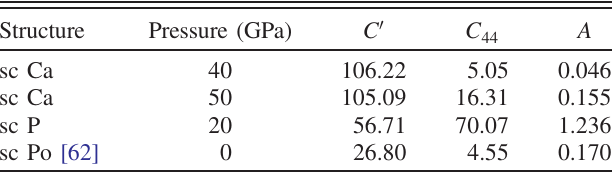
TABLE II. The calculated values of elastic anisotropy factor A for selected elements with simple cubic structure. The results of sc Po were taken from Ref. [62].